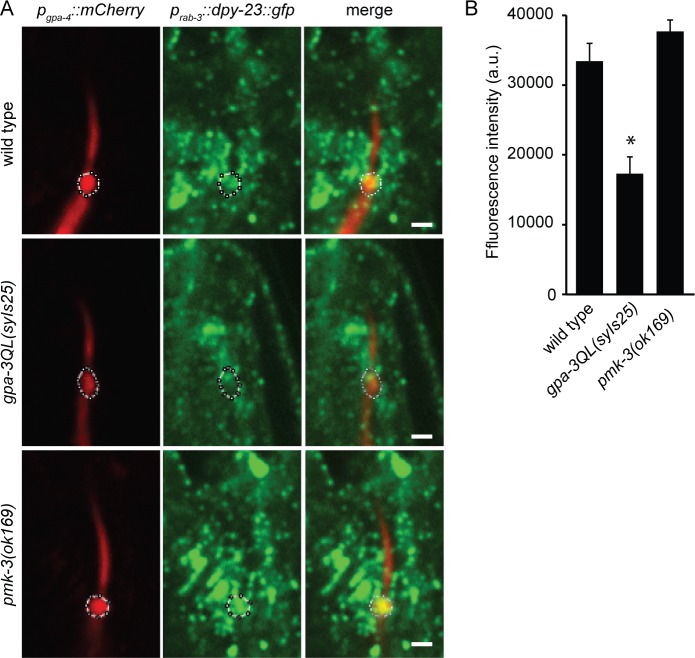
DPY-23::GFP levels are decreased in gpa-3QL mutant animals.(A) Fluorescence images of DPY-23::GFP in all neurons, combined with mCherry expressed specifically in the ASI neurons of the indicated strains. The region at the base of the cilium, used to quantify DPY-23::GFP intensity levels, is indicated with a dotted line. Exposure time and laser intensity were kept constant. Anterior is at the top. Scale bar 1 μm. (B) Mean GFP fluorescence intensities of the selected regions at the base of the cilium of the indicated strains. 12 animals were imaged per genotype. Fluorescence intensity in gpa-3QL(syIs25) animals was significantly different from wild type (p<0.05). Error bars indicate SEM. Statistical analysis was performed using an ANOVA, followed by a Bonferroni post hoc test.